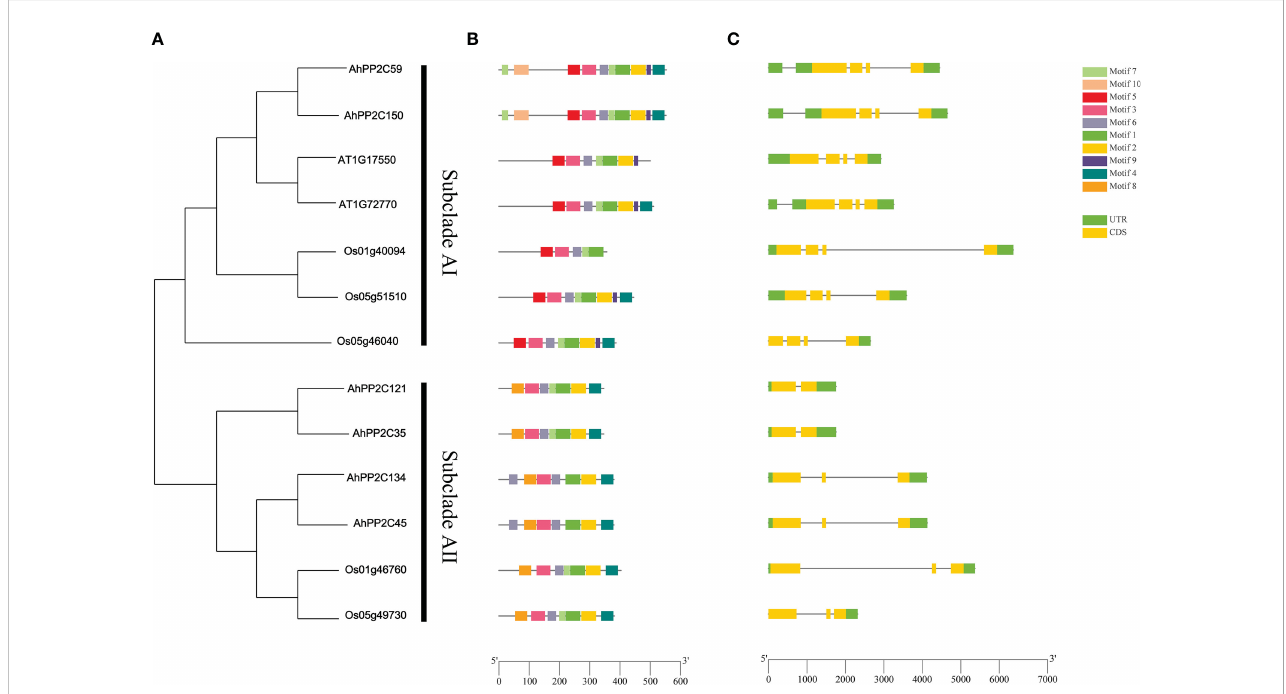
FIGURE 6 Phylogenetic relationship, gene structures and motifs analysis of PP2Cs in subclades AI and AII. (A) Phylogenetic tree of PP2Cs (B) Motifs analysis of PP2Cs. Colored boxes indicate the different conserved motifs as indicated in the scheme to the right of the fi gure. (C) Exon-Intron Structure of PP2C s, where exons are shown as yellow boxes. Where present, 5 ’ and 3 ’ UTRs are depicted as green